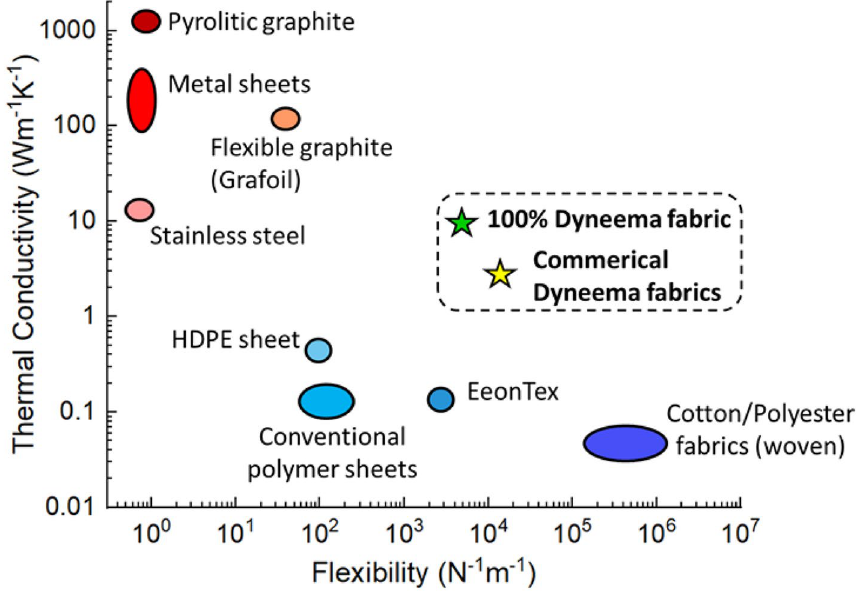
Figure 7. Thermal conductivity versus flexibility (inverse of bending stiffness) for different materials. The materials shown in shades of red (top left) are conventional heat spreaders and possess low flexibility, while those shown in shades of blue (bottom center-right) represent conventional polymer and fabric materials with high flexibility and low thermal conductivity. Dyneema fabrics (stars) break the trend by demonstrating significantly higher thermal conductivity relative to polymers, while retaining good mechanical flexibility. Data for standard materials (not characterized in this study) taken from references 48–52